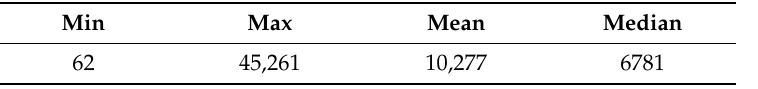
Table 1. Population distribution statistics per Voronoi for Greater Maputo.